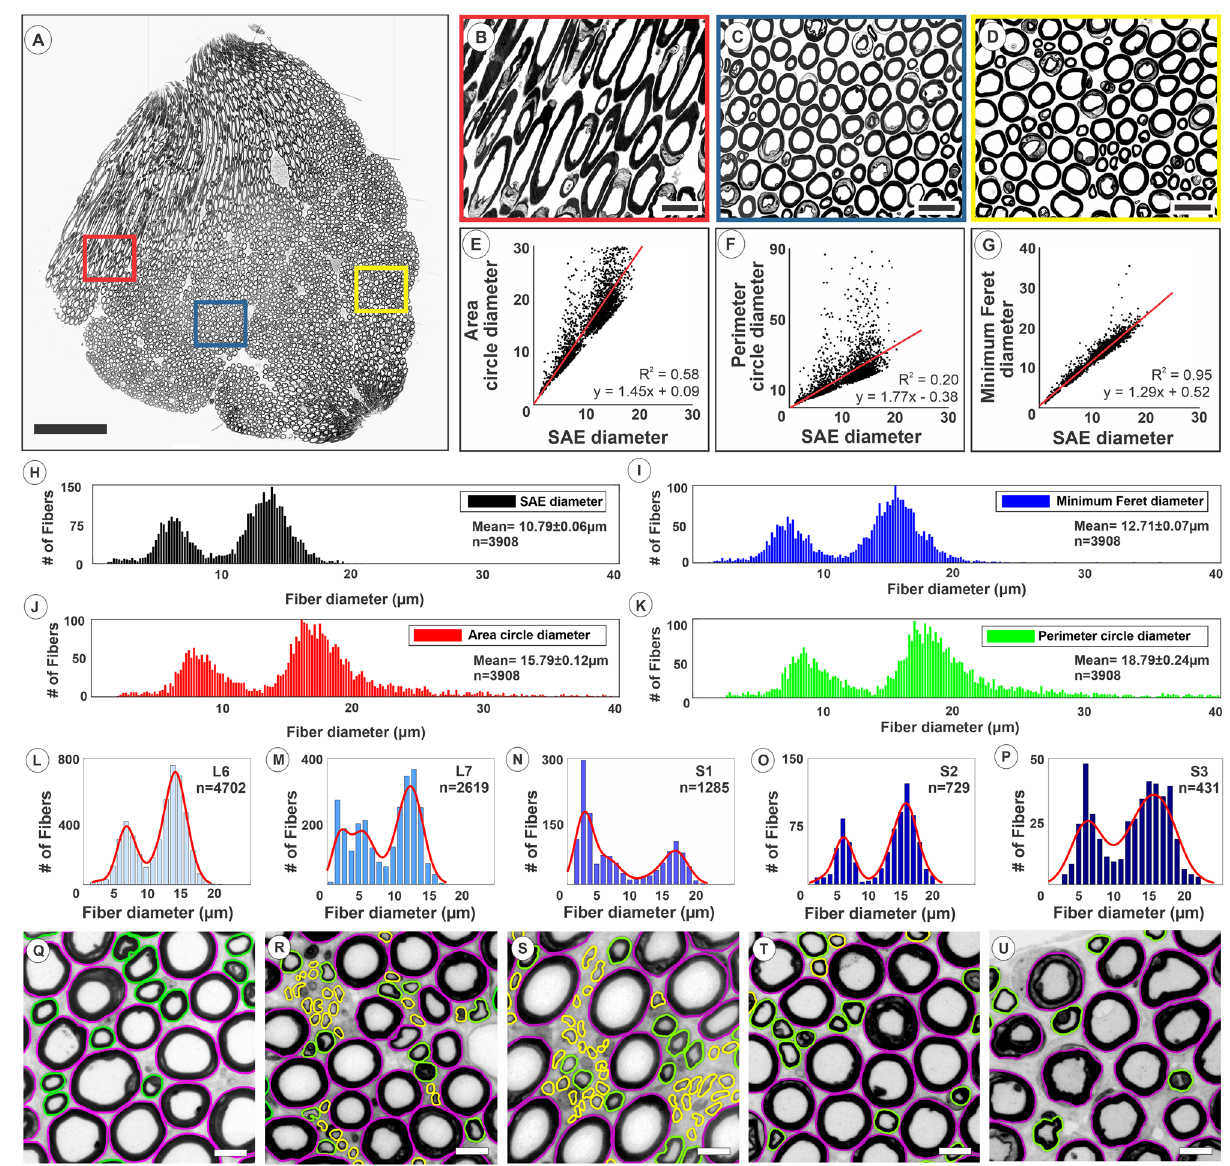
Figure 2. Validation of myelinated nerve fiber size determination using a SAE approach. ( A ) Light micrograph of a transverse section of an L6 VR in a rhesus macaque. Segmentation of all myelinated axons in the micrograph showed a total of 3,908 fibers. Red, blue, and yellow boxes show regions of interest depicted at higher magnification in ( B–D ) Note elongated fibers merging into main body of this proximal VR segment in ( B ). ( E–G ) Correlation graphs between calculated fiber diameter after SAE correction and corresponding diameters obtained by determining the Feret minimum diameter in or calculating the diameter based on the formula for the area or perimeter of a circle. Note dispersion of fiber diameters, especially for large diameter fibers based calculations using the circle formula approaches. ( H–K ) Frequency distribution graphs for myelinated fiber diameters determined using the SAE approach, Feret minimum diameter, and by calculating the diameter based on the formula for the area or perimeter of a circle. Note right-shift to larger diameters for both the γ- and α-motor fiber peaks and overestimation of diameters to non-physiologic range in estimates based on the formula for a circle. ( L–P ) Frequency distribution graphs for fiber diameters of myelinated axons in the L6–S3 VRs of one representative rhesus macaque. ( Q–U ) Representative areas of L6–S3 corresponding ROIs for segmented contours of myelinated fibers. Fibers with a diameter range of 0–4 µm are depicted in yellow, > 4–10 µm in green, and > 10 µm in magenta. Note presence of predominantly the smallest fibers of the 0–4 µm diameter range, corresponding to myelinated autonomic fiber size, in the L7 and S1 VRs in this subject. Scales: 500 µm in ( A ); 50 µm in ( B–D ); 20 µm in ( Q–U